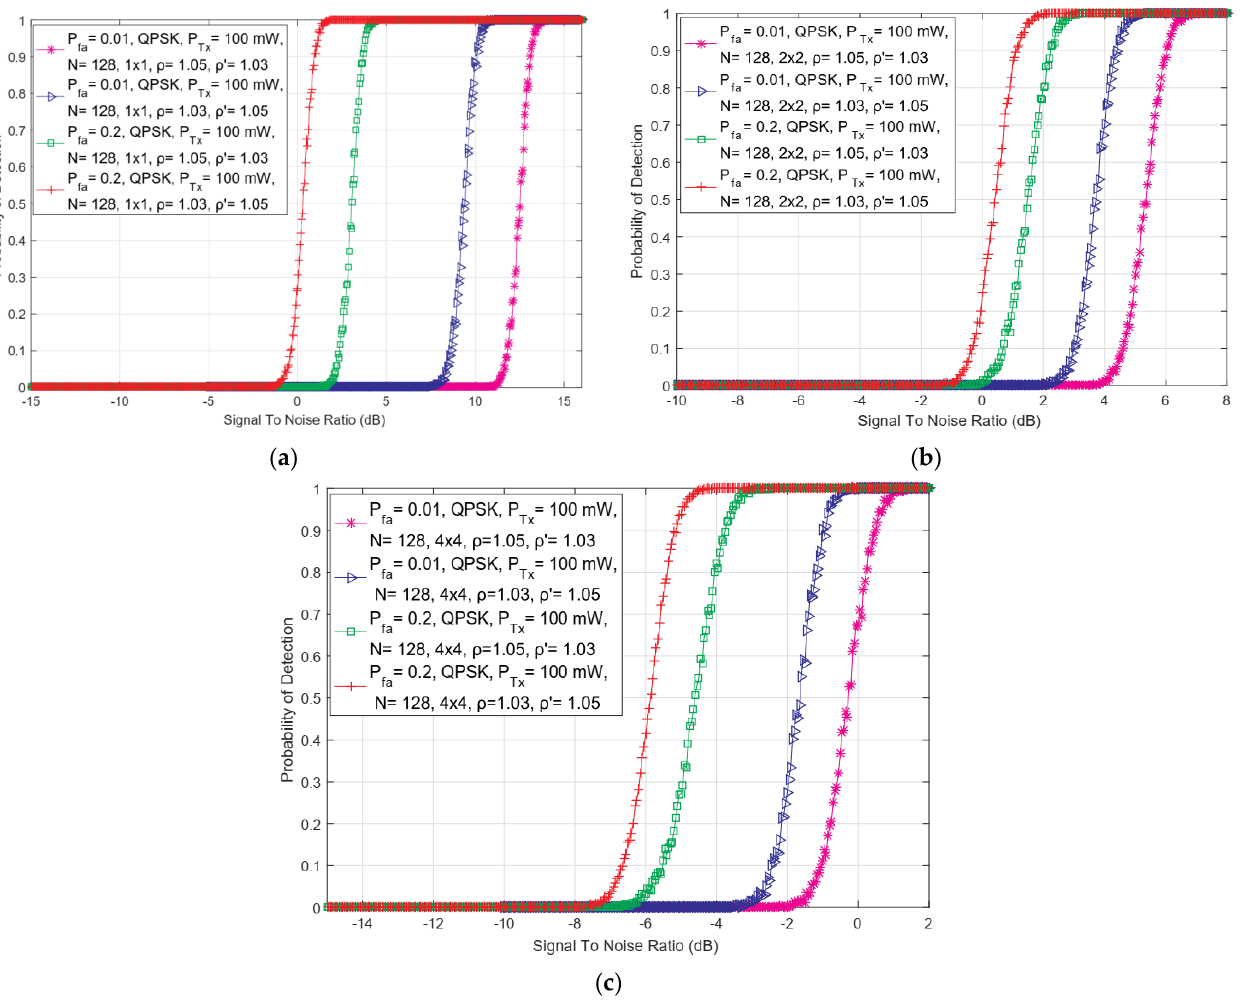
Figure 8. The dependency of detection probability on SNR for ED performed with different false alarm probabilities and combinations of DDT and NU factors in ( a ) SISO, ( b ) 2 × 2 symmetric MIMO and ( c ) 4 × 4 symmetric MIMO communication systems.